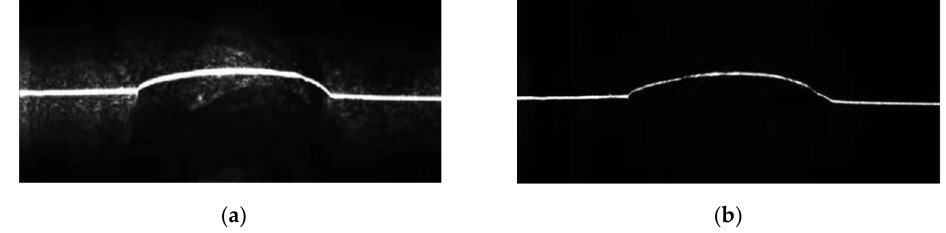
Figure 3. Structured-light image noise reduction process: ( a ) original structured-light image; ( b ) structured-light image after denoising.